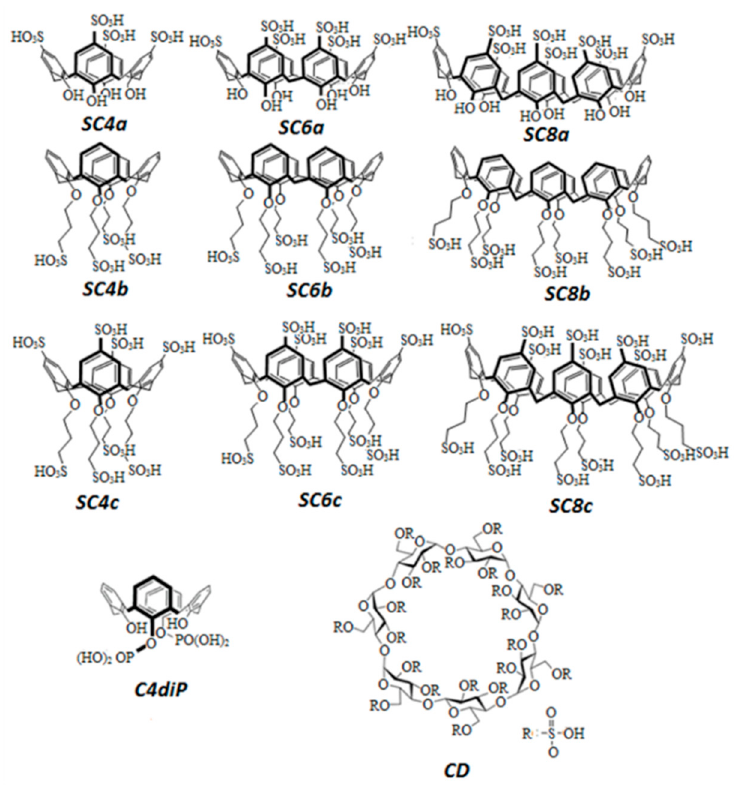
Scheme 1. Structures of the molecules used in the current